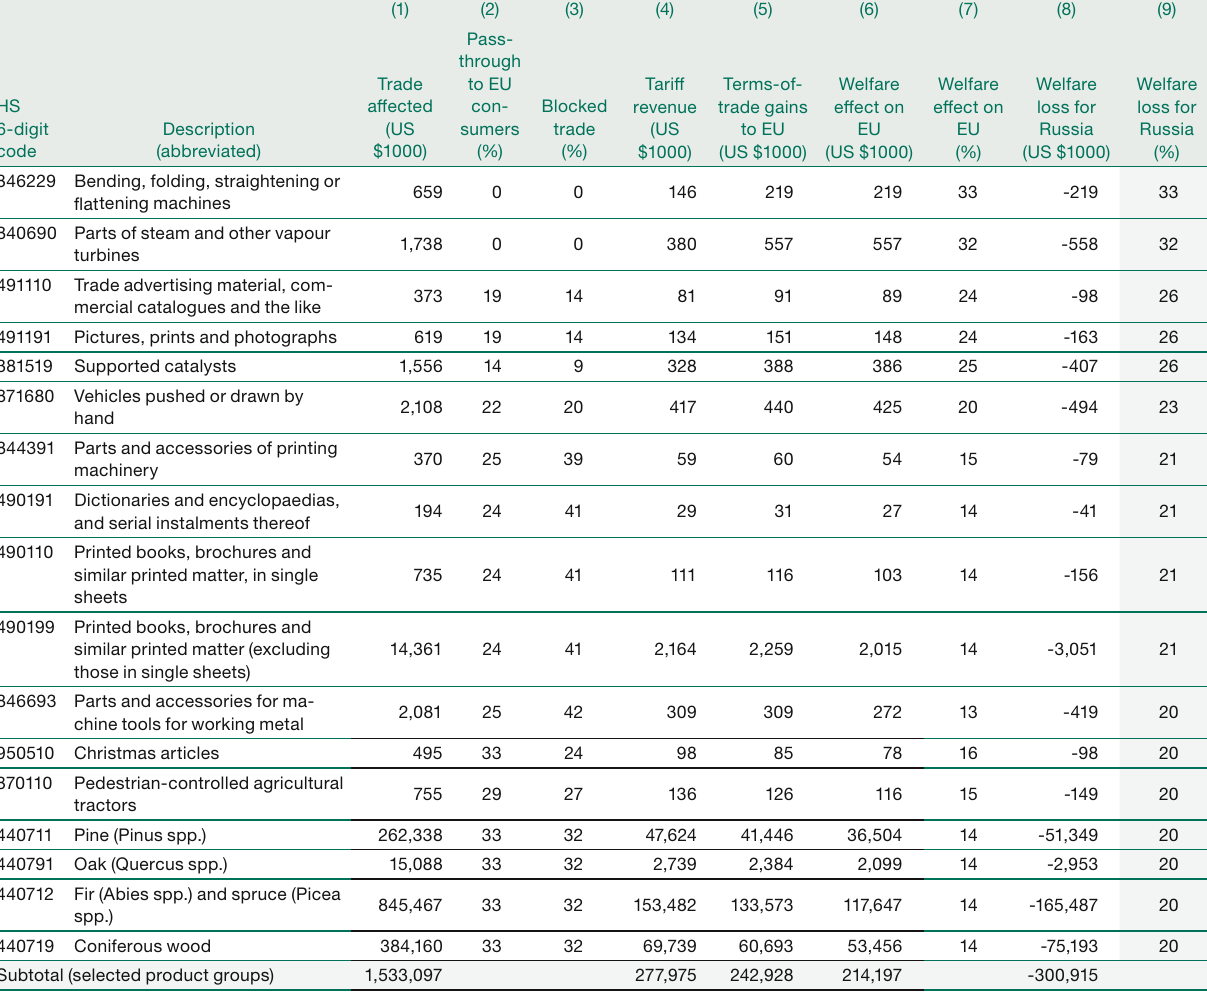
Sectors with high relative welfare losses to